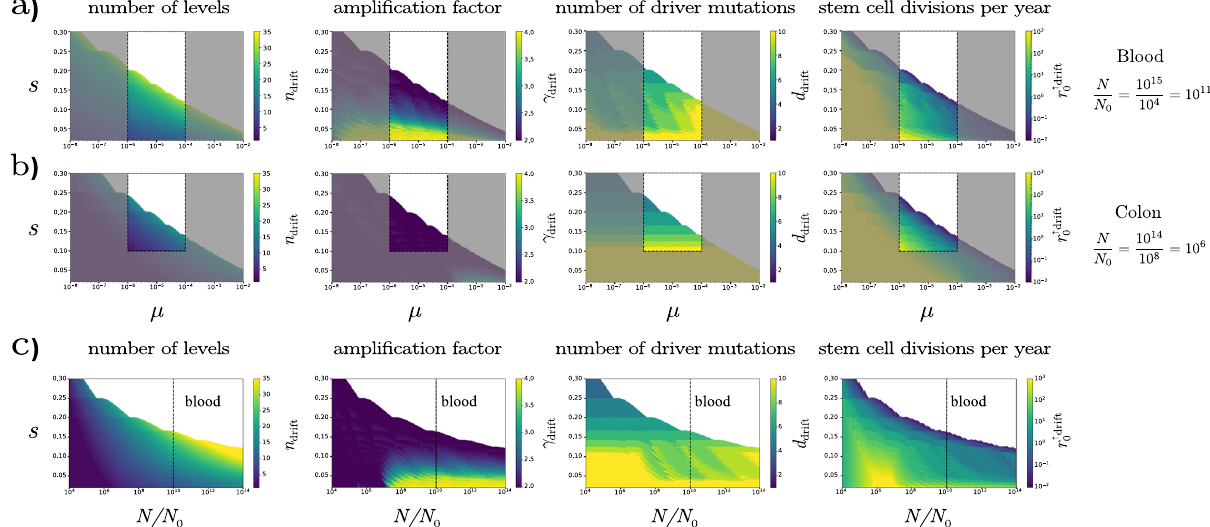
Fig. 3 The organization of hierarchical tissues that have evolved to limit somatic evolution. We consider the least complex tissue, i.e., the one with the smallest number of hierarchical levels that can keep the lifetime risk of cancer below a speci fi c value set by the “ drift-barrier ” (see Methods for details). a For the hematopoietic system, where N 0 = 10 4 stem cells produce approximately N = 10 15 mature cells during an individual ’ s lifetime we consider a threshold lifetime risk of about 2%. b For the colon, where N 0 = 10 8 and N = 10 14 we consider a threshold of about 4%. Each panel shows the value of a given parameter of the least complex tissue for different values of s and μ . For both tissues, the area delimited by the dashed lines corresponds to the most realistic values for μ and s based on the literature, as discussed in the main text. c To explore tissues with different values of N / N 0 we keep N = 10 15 , μ = 10 − 5 and the maximum acceptable lifetime risk of 2% fi xed, but change the ratio N / N 0 . The dashed line corresponds to the value for the hematopoetic